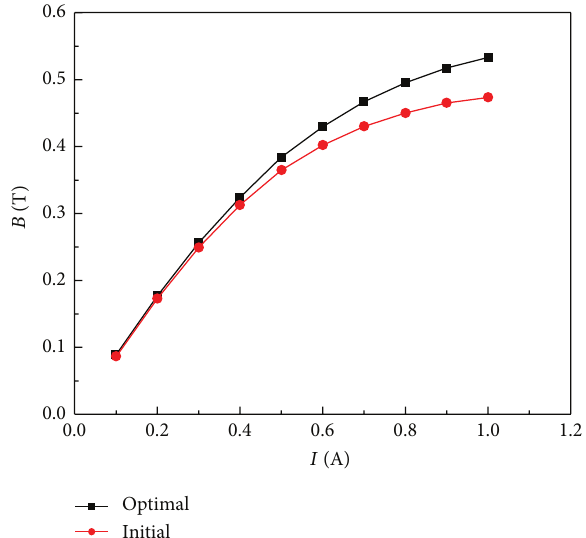
Figure 10: Comparison of magnetic flux density between initial design and optimal design.